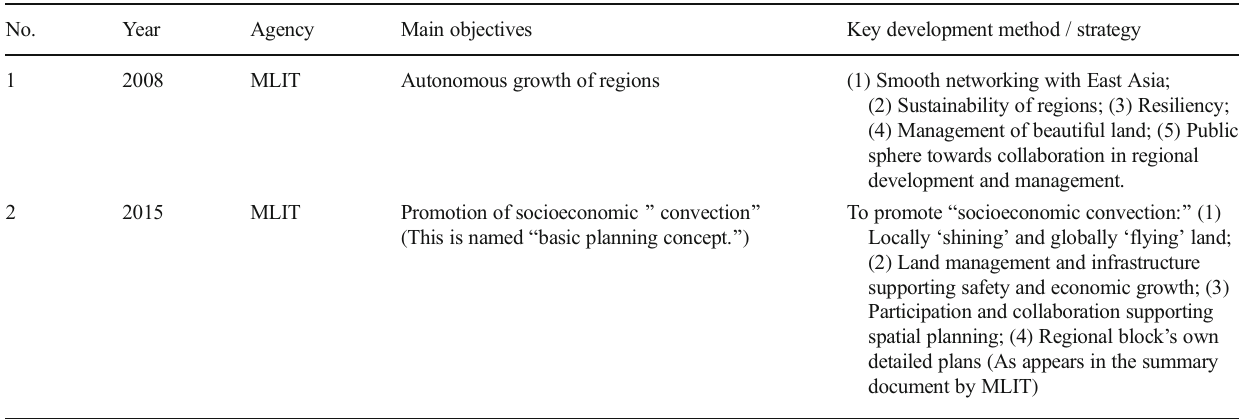
List and brief summaries of the national land formation plans at the national level (Own summary based on [22, 23])